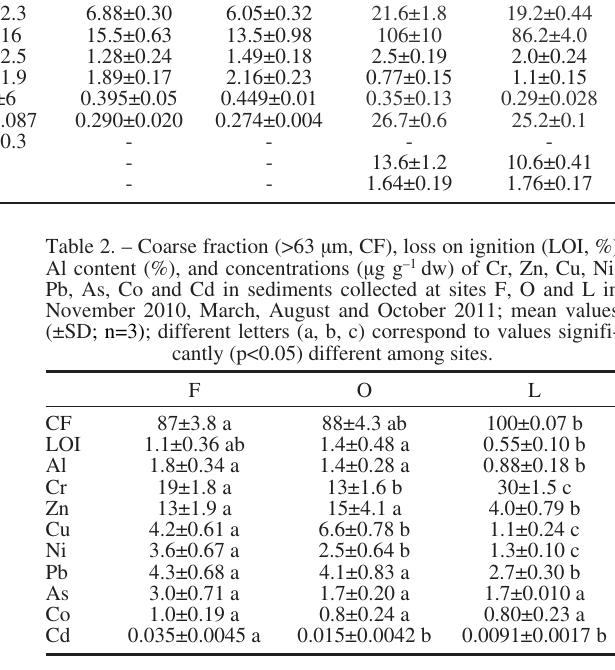
Table 1. – Certified (mean±uncertainty) and obtained (mean±standard deviation) Zn, As, Cu, Ni, Cr, Pb, Cd, Co, Mn and V concentrations (μg g –1 ) in the replicates (n=3) of certified reference materials. Element